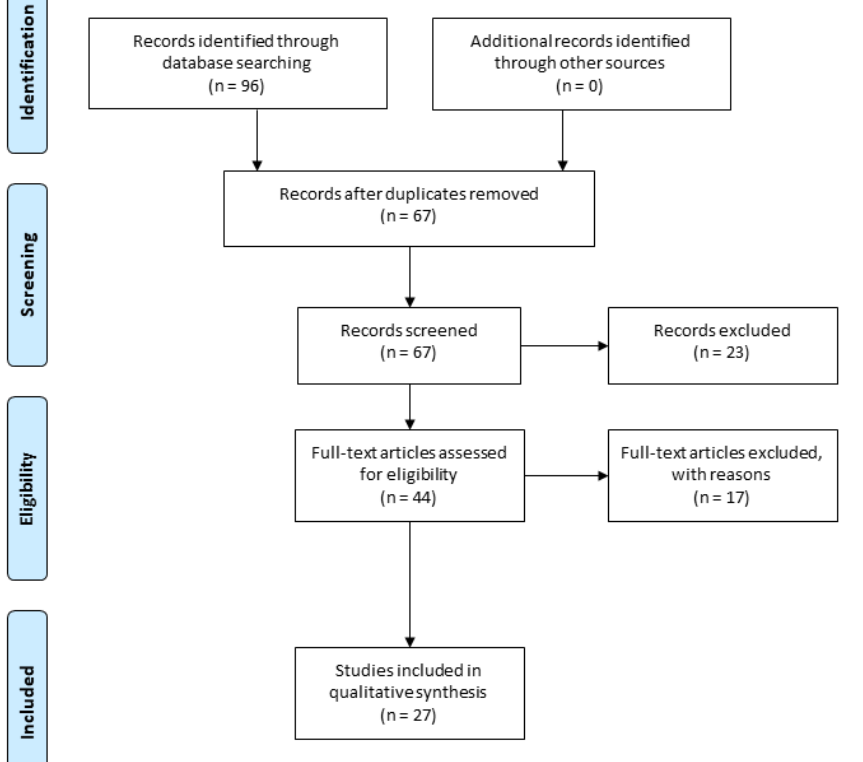
Figure 1. Prisma flow diagram illustrating the selection methodology of the preclinical studies used for the writing of the review. Duplicate articles were excluded from the total of the studies recorded. Instead, articles that evaluate the biochemical and molecular mechanisms underlying the effects of CBD and its therapeutic application in neurological diseases are considered (The PRISMA Statement is published in [42]).